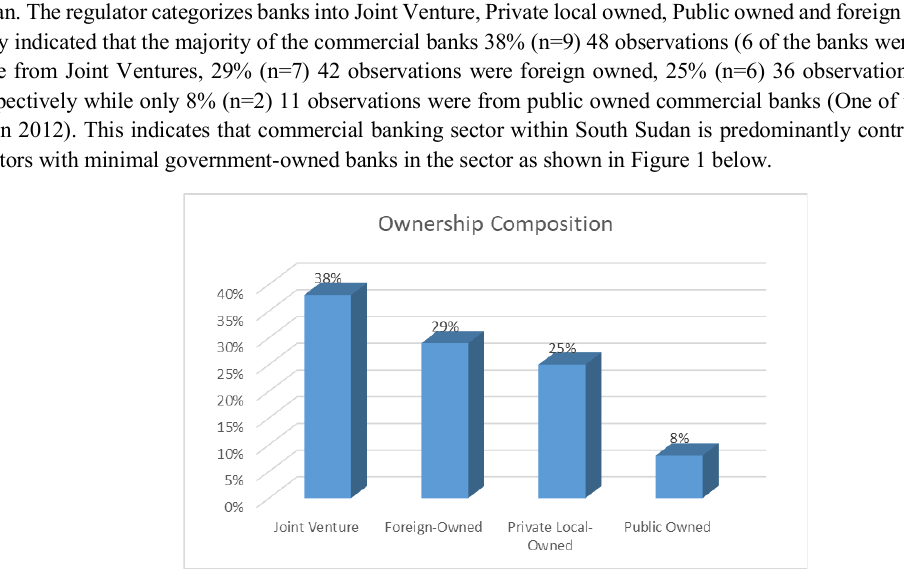
Figure 1: Ownership Structure